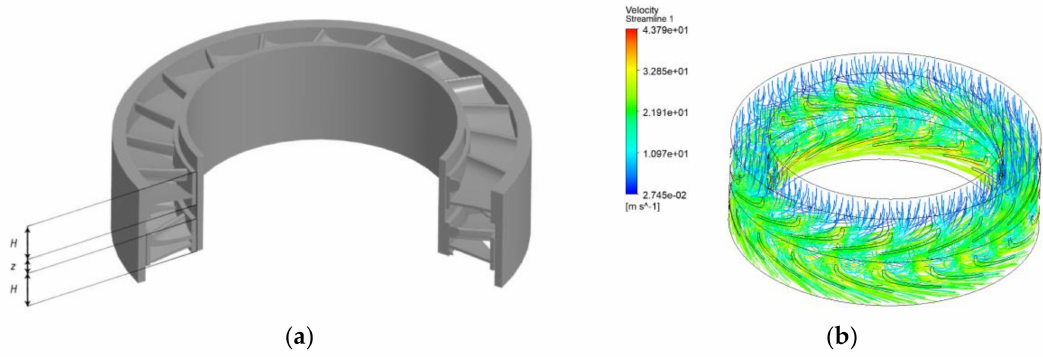
Figure 3. Modeling a working turbine pair: ( a )—Model of a turbodrill, where H—section height, and z—gap between sections; ( b )—Display of the flow of fluid flows in the developed turbine